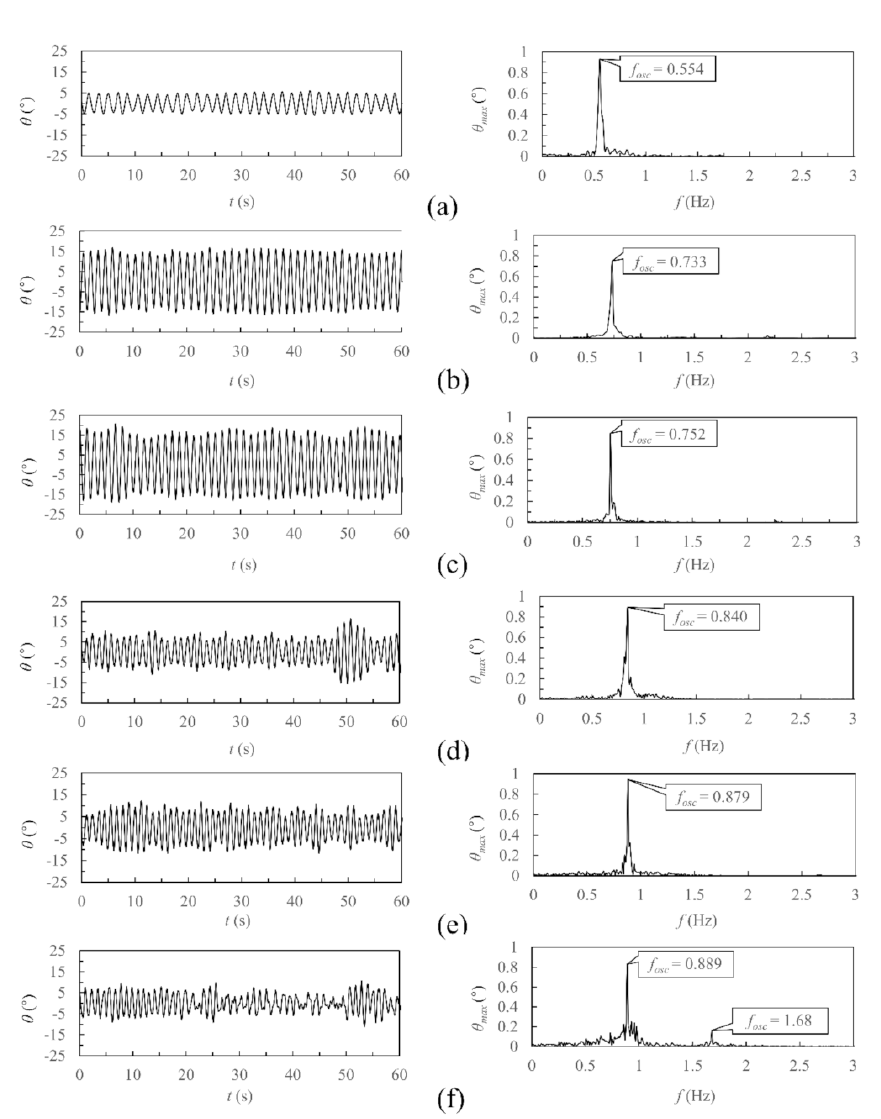
Figure 13. Rotational oscillation time history and spectral characteristics at six typical velocities when L / D = 4.5: ( a ) U = 0.302 m/s ( U r = 2.764); ( b ) U = 0.483m/s ( U r = 4.428); ( c ) U = 0.519 m/s ( U r = 4.76); ( d ) U = 0.592 m/s ( U r = 5.426); ( e ) U = 0.665 m/s ( U r = 6.091); ( f ) U = 0.882 m/s ( U r =